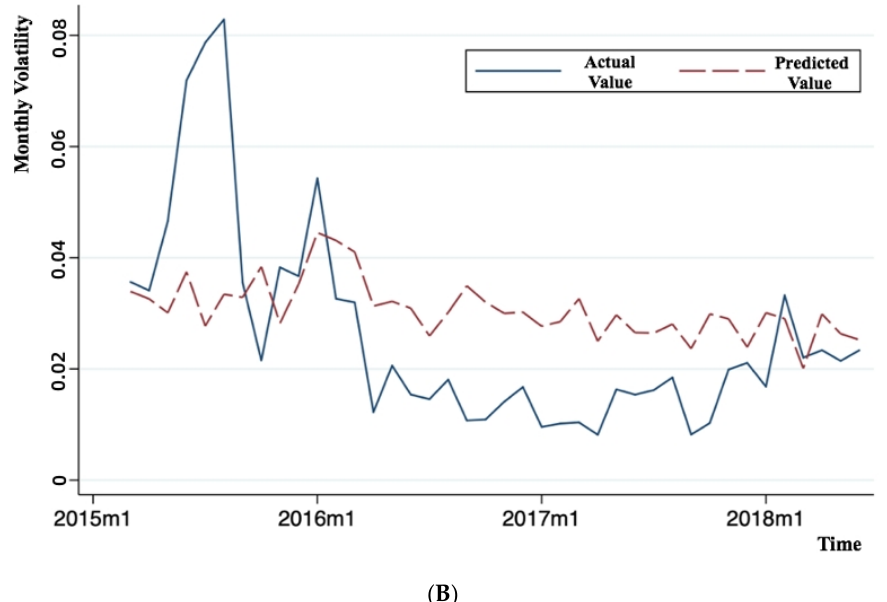
Figure 5. The predicted and actual monthly volatility: LASSO regression. Panel ( A ) presents the predicted and actual monthly volatility of the SSE 50 index before introducing the index options and Panel ( B ) presents the predicted and actual monthly volatility of the SSE 50 index after introducing the index options.